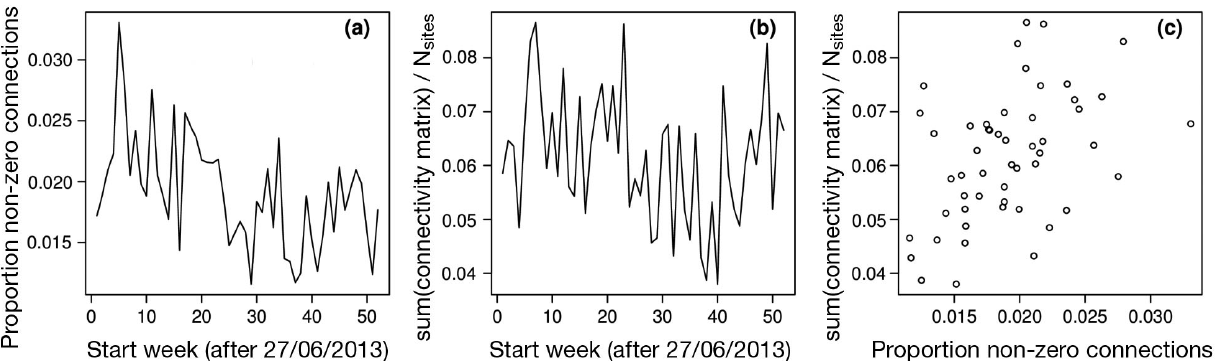
Fig. 2. Total connectivity over time. (a) Proportion of possible connections that were non-zero for each of the 52 weekly simula- tions. (b) Sum of the connectivity matrix, divided by the number of sites, for each weekly simulation. (c) Scatter plot of total connectivity against proportion of non-zero